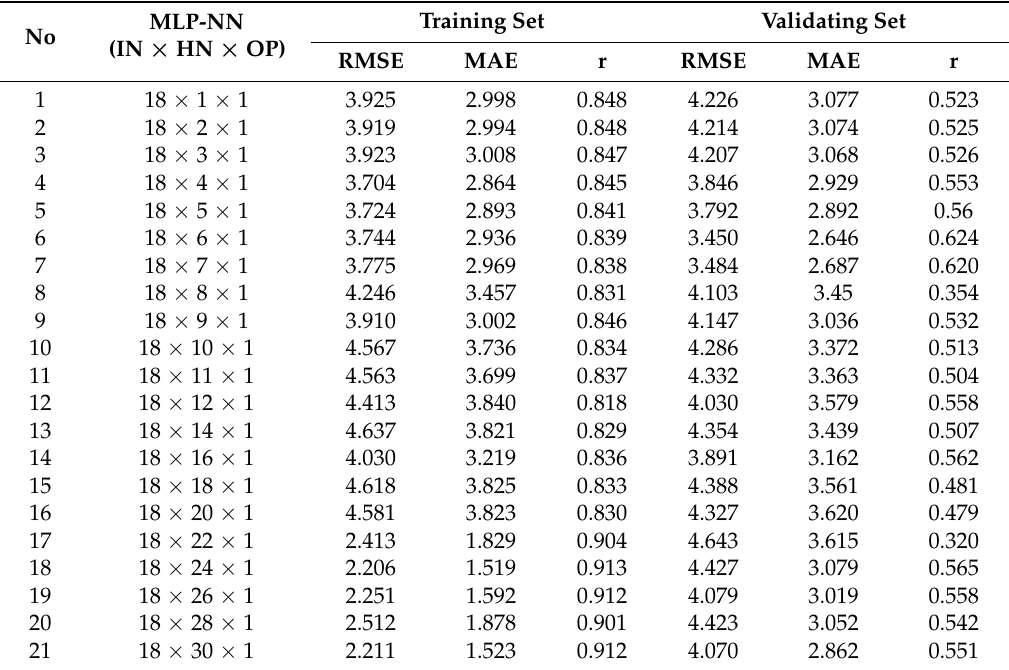
Table 2. Performance of multilayer perceptron NN (MLP-NN) versus its hidden neurons (IN: Input neuron; HN: Hidden neuron; OP: Output).